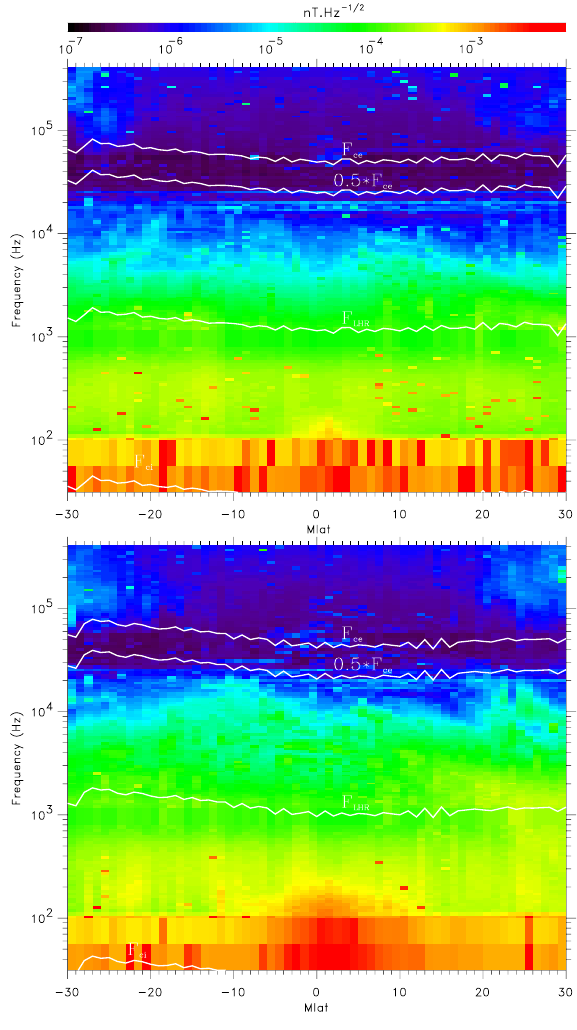
Fig. 4. Variation in Mlat values of the amplitude spectra averaged over L -values running from 1 to 5.5. The top panel corresponds to spectra recorded during periods of weak geomagnetic activity and the bottom panel to spectra recorded during periods of strong geomagnetic activity.